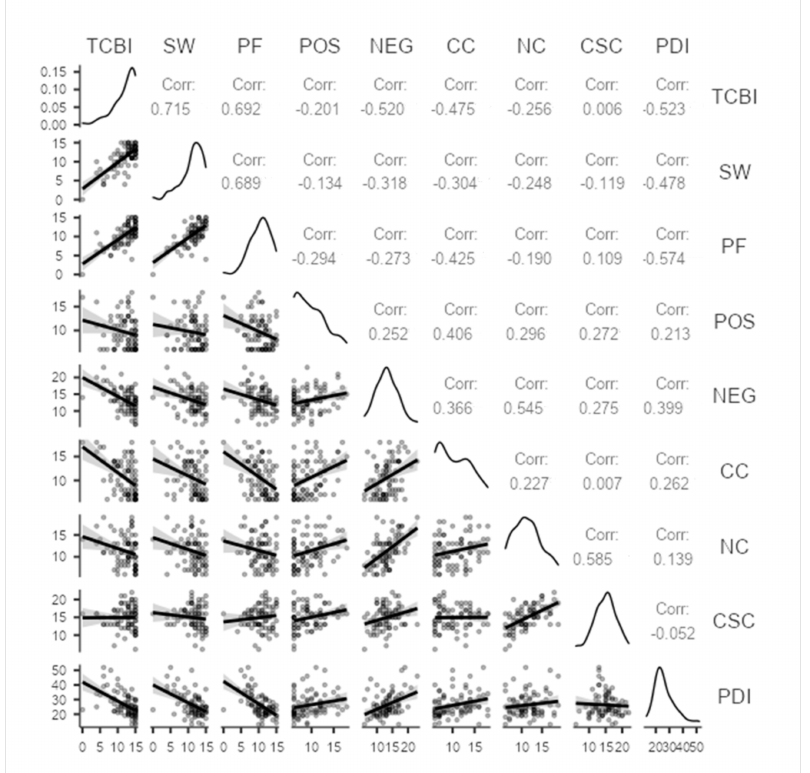
Figure 3. Pearson r correlations between PDI, BSPq, and MCQ-30 scores for the